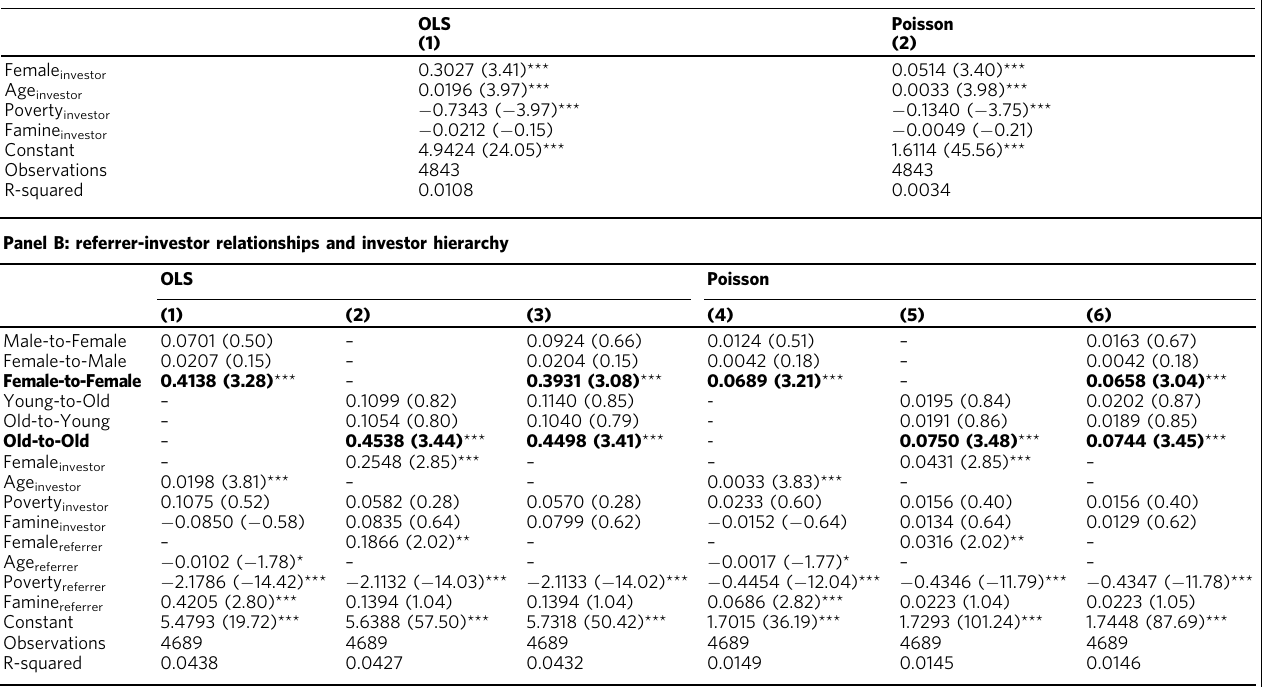
Table 4 Investor gender/age, referrer-investor relationships, and investor hierarchy. Panel A: investor gender/age and investor hierarchy